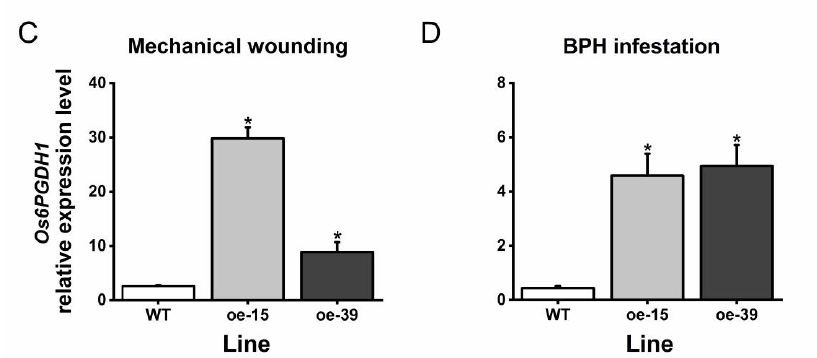
Figure 4. Molecular confirmation of transgenic lines overexpressing Os6PGDH1 . ( A ) Southern blot of Os6PGDH1 -overexpressing lines and WT plants. Genomic DNA from oe-15, oe-39, and WT plants was digested with EcoR I and Xba I, respectively. Digested genomic DNA was hybridized to a specific GUS probe. ( B ) Basal expression levels (means + SE, n = 5) of Os6PGDH1 in oe6PGDH lines and WT plants; ( C , D ) relative transcript levels (means + SE, n = 5) of Os6PGDH1 in oe6PGDH lines and WT plants that were mechanically wounded or infested by gravid BPH females for 12 h (these experiments were performed separately). Asterisks indicate significant differences in oe6PGDH lines compared with WT plants (one-way ANOVA followed by Duncan’s multiple range test, p < 0.05).